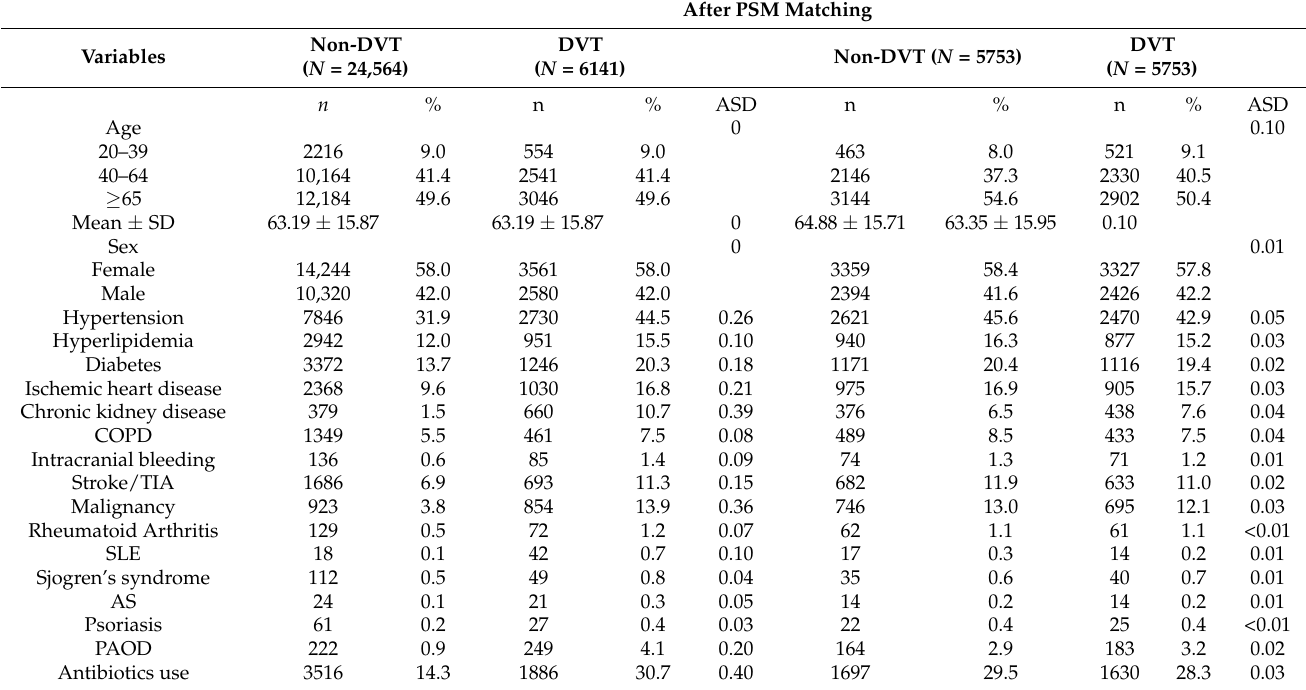
Table 1. Demographic characteristics of DVT and non-DVT patients.